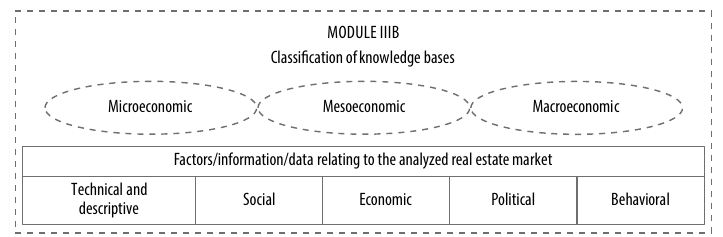
Factors/information/datarelatingtotheanalyzedreal estate market Technicaland Fig. 2. Module IIIb of the rating procedure diagram